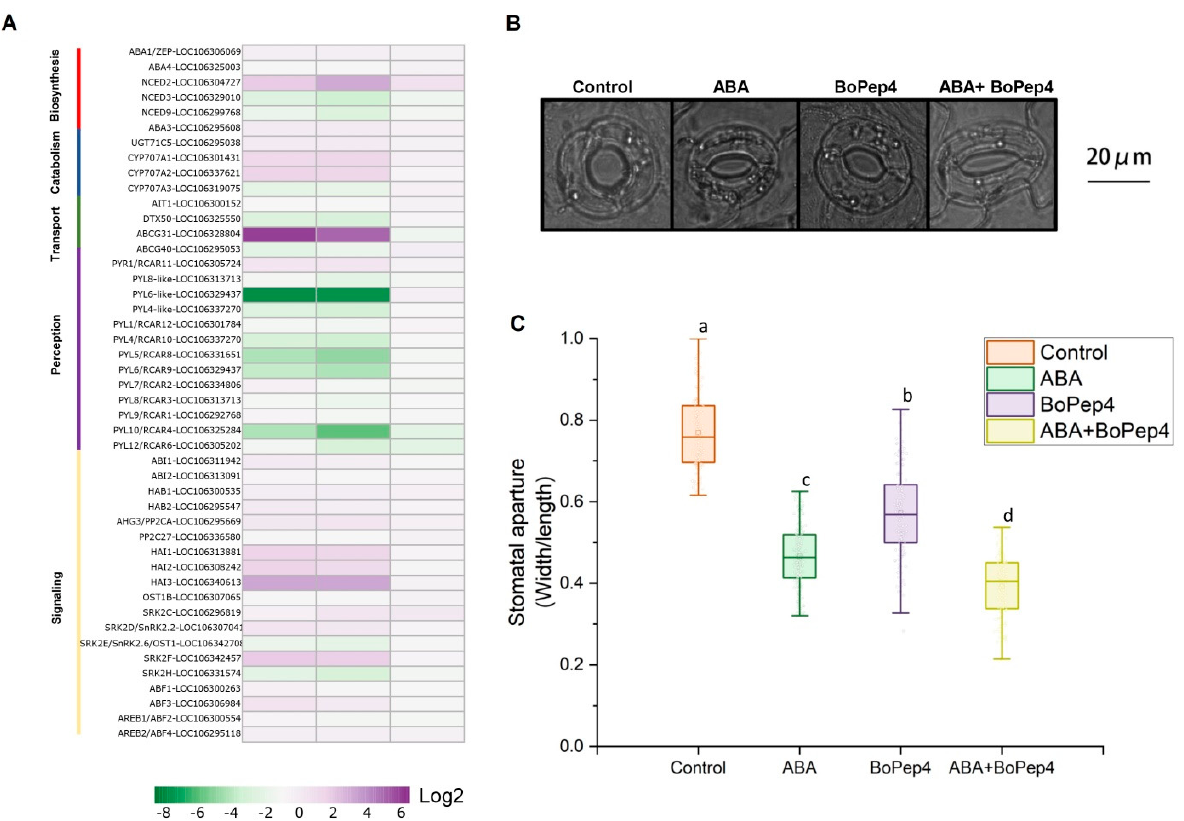
Figure 6. BoPEP4 treatment alters ABA response under salt stress. ( A ) The expression of the genes associated with ABA biosynthesis, metabolism, transport, perception and signaling in CR, PR and NR analyzed by RNA sequencing. The detailed expression data are available in Table S6. ( B ) Rep- resentative images of guard cells of broccoli treated with ABA, PEP and ABA + PEP. Bars = 20 µm. ( C ) Stomatal aperture (the ratio of stomatal width to length) measurements of guard cells of broccoli treated with ABA, PEP and ABA + PEP. In each experiment, 150 stomata from separate seedlings were measured. Three independent experiments were performed. Different letters represent significant differences according to Duncan’s multiple range tests ( p < 0.05).